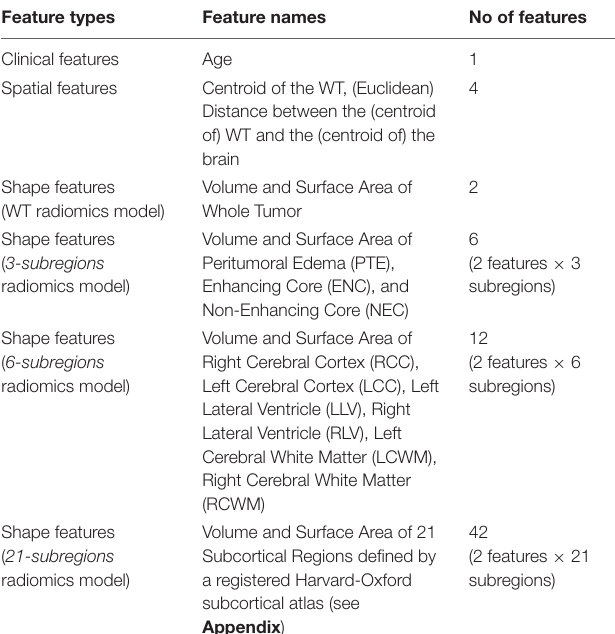
TABLE 3 | Summary of radiomic features extracted for four radiomic models, namely, the WT radiomics model, the 3-subregions radiomics model, the 6-subregions radiomics model, and the 21-subregions radiomics